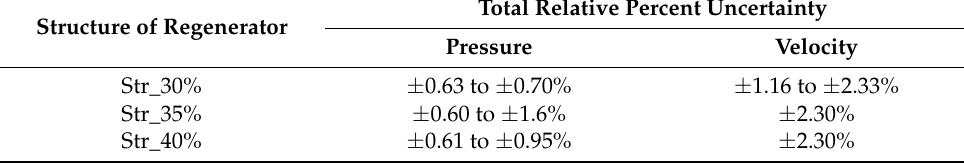
Table 1. Total relative percent uncertainty of experiment.